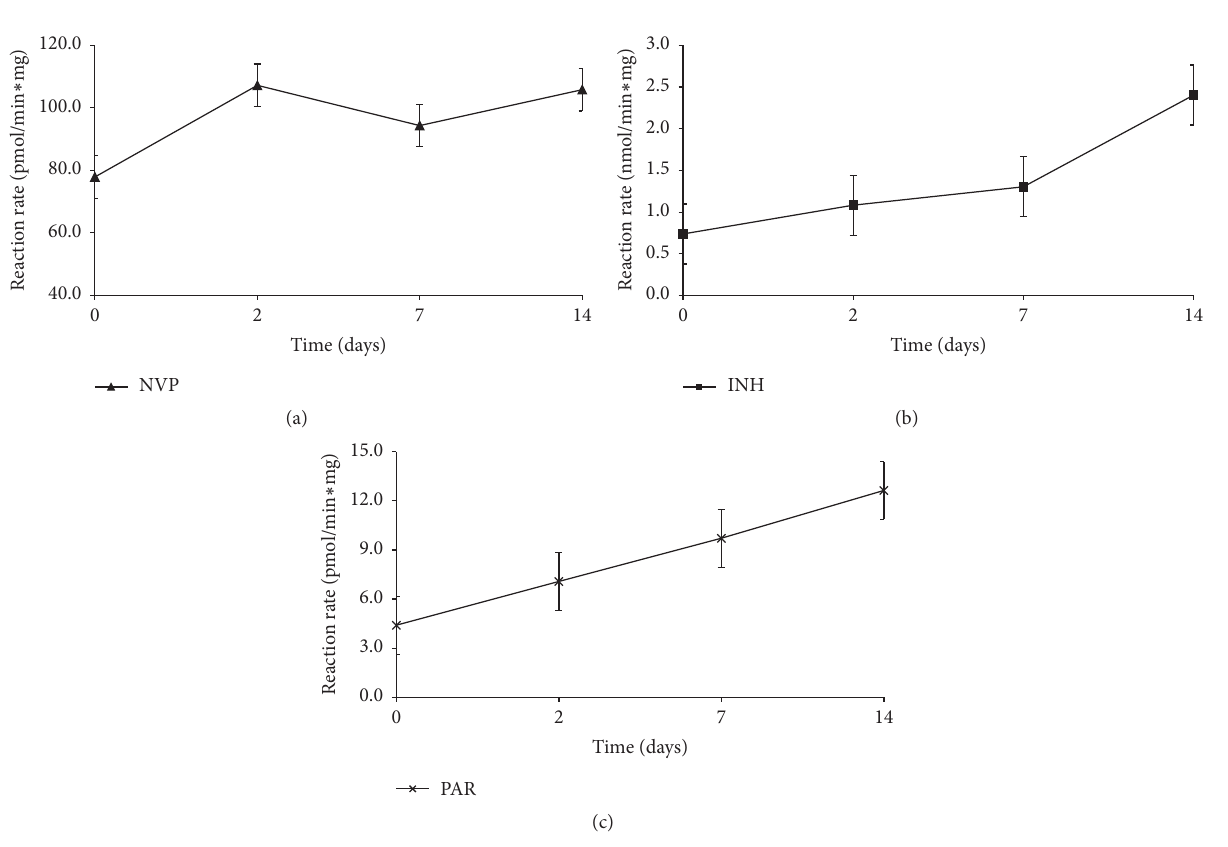
Figure 5: CYP3A2 activity in rats treated daily with NVP (a), CYP2E1 activity in rats treated daily with INH (b), and CYP1A2 activity in rats treated daily with PAR